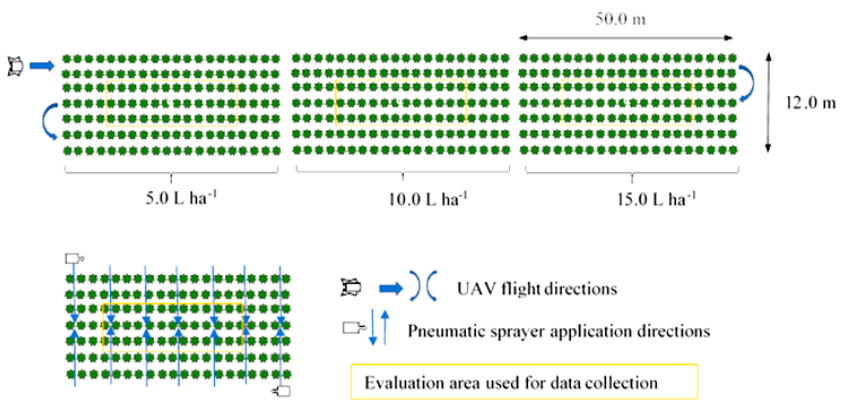
Figure 3. Experimental design.